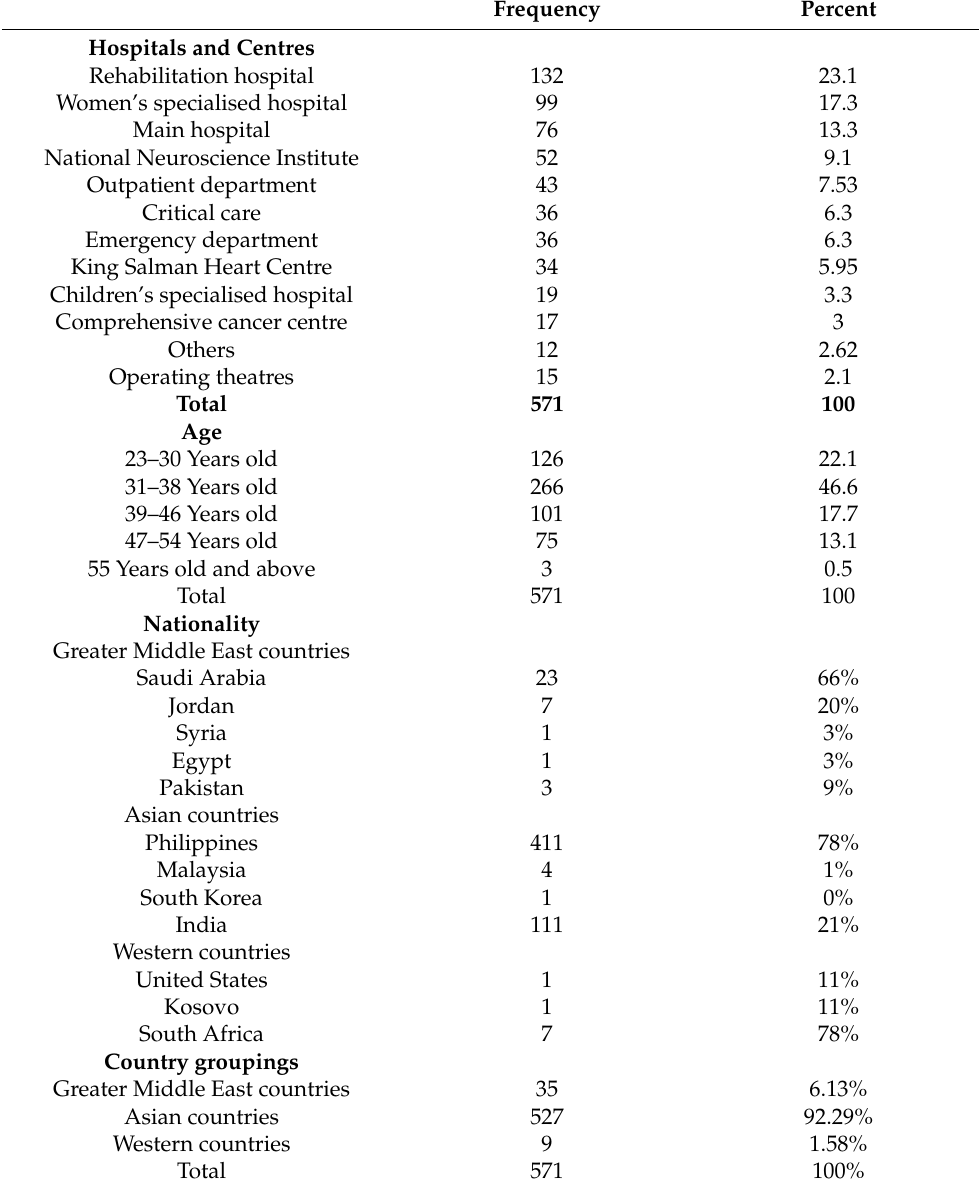
Table 3. Sociodemographic profile: quantitative phase ( n =